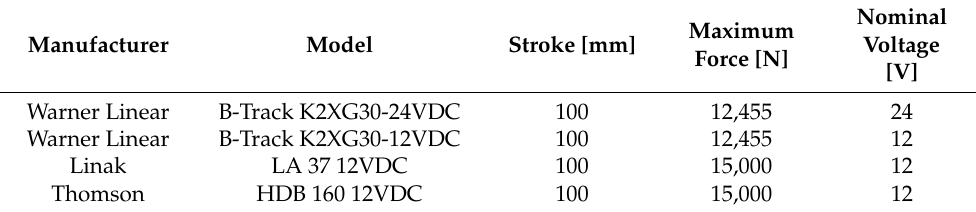
Table 3. Different linear electric actuators initially considered in this